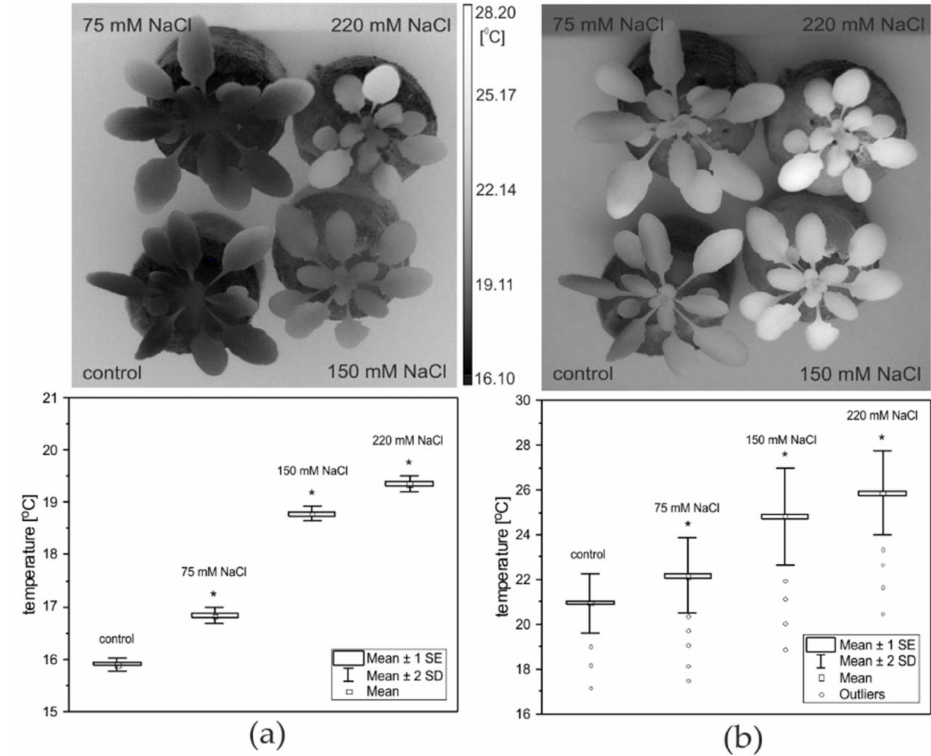
Figure 4. Infrared thermograms of LL-growing ( a ) and HL-treated ( b ) A. thaliana plants acquired three days after exposure to salinity ( upper panel ), and the average temperature distribution over the leaf rosettes of control and salt-treated plants ( lower panel ). Data are presented as box-and-whisker plots showing mean, standard error, and the outliers at the 95% confidence level. An asterisk (*) indicates significant differences ( p ≤ 0.05, ANOVA test) between the non- and salt-treated plants before (LL) and after an acute HL